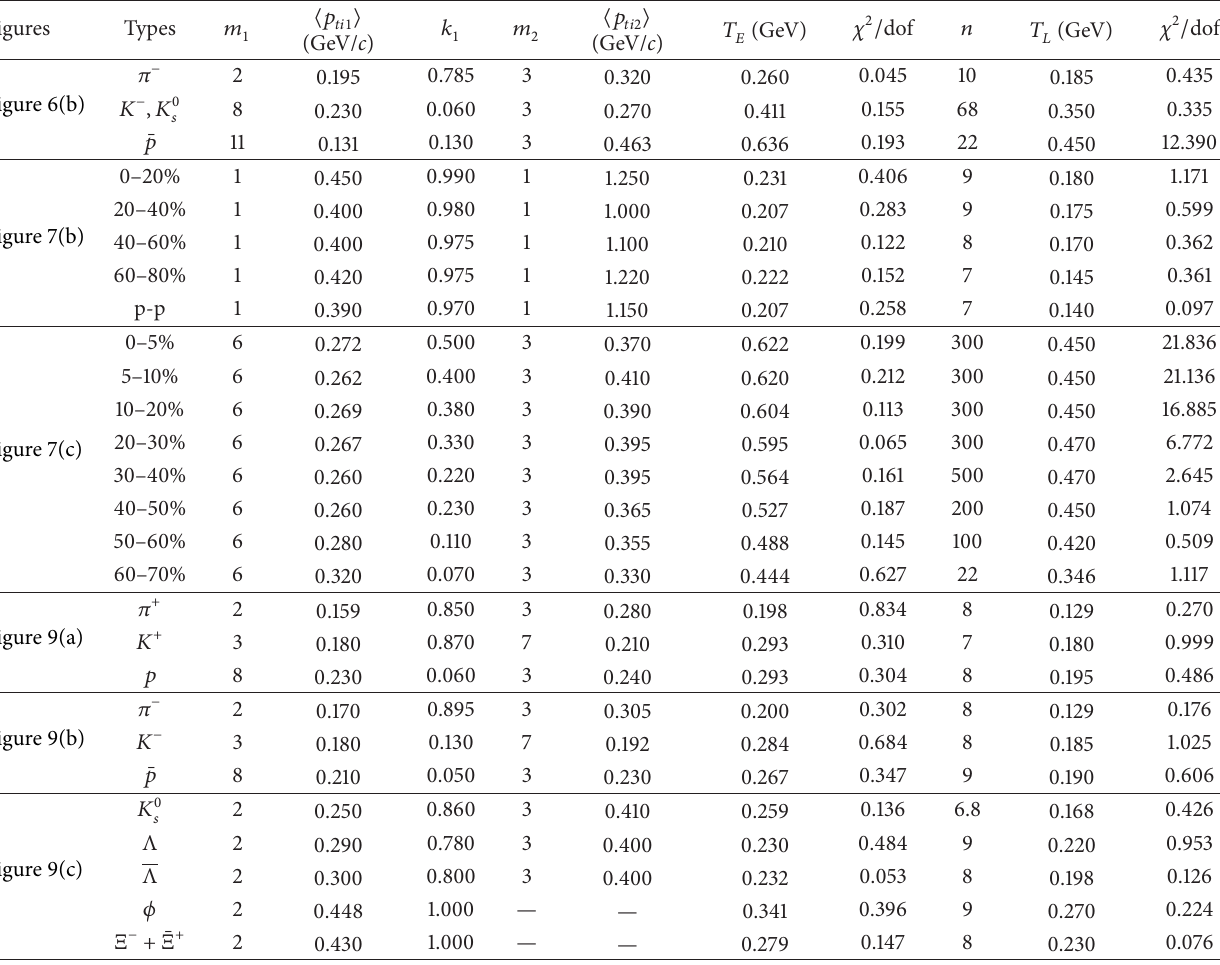
Table 5: Parameter values for the two kinds of curves in Figures 6(b), 7(b), 7(c), and 9. The values of 𝜒 2 / dof and extracted temperatures are given. The errors for 𝑚 1 , 𝑚 2 , and 𝑛 can be neglected, and the relative errors for other parameters are less than 10%.